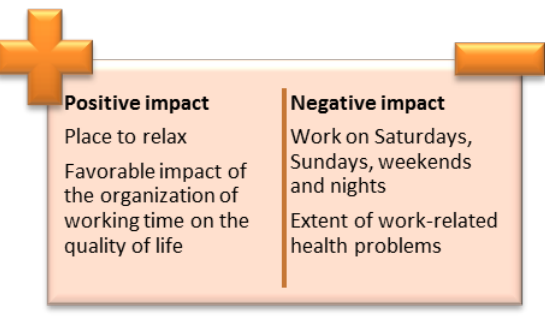
Figure 1 : Factors determining the subjective assessment of working conditions in an enterprise Source: Own estimates of the target survey